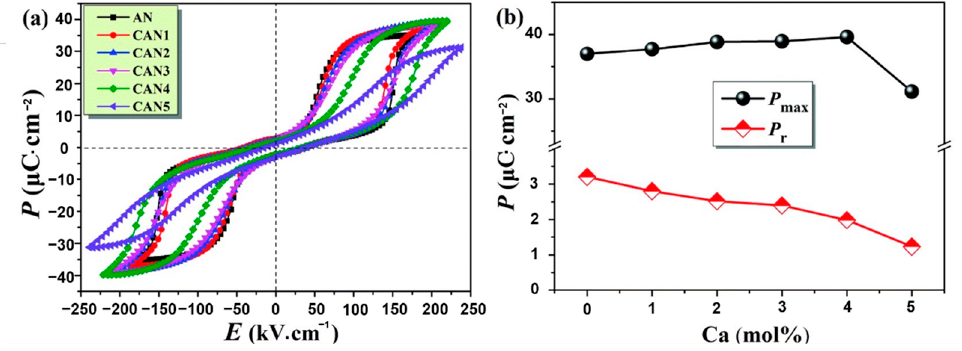
Figure 14. Ag 1 − 2x Ca x NbO 3 (CANx) ceramics. ( a ) P–E loops; ( b ) P max and P r . Reprinted with pemission from [75]. Copyright 2019 Royal Society of Chemistry.